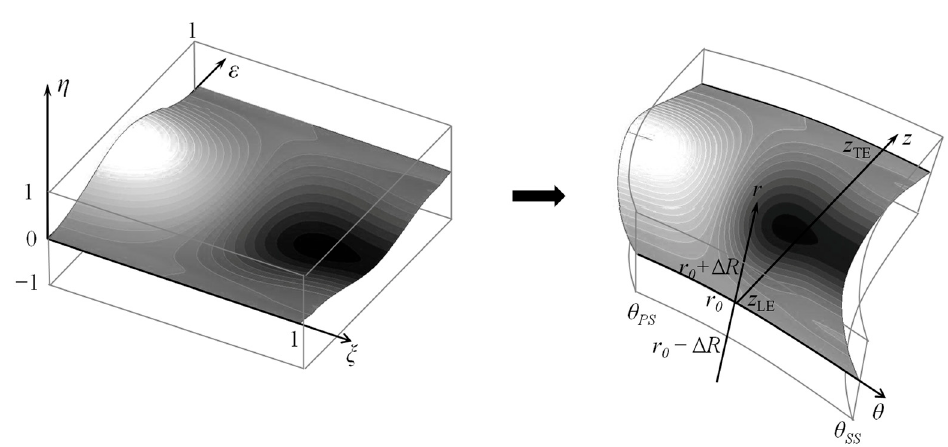
Figure 5. Mapping from the standard space to the end wall region of a compressor passage.